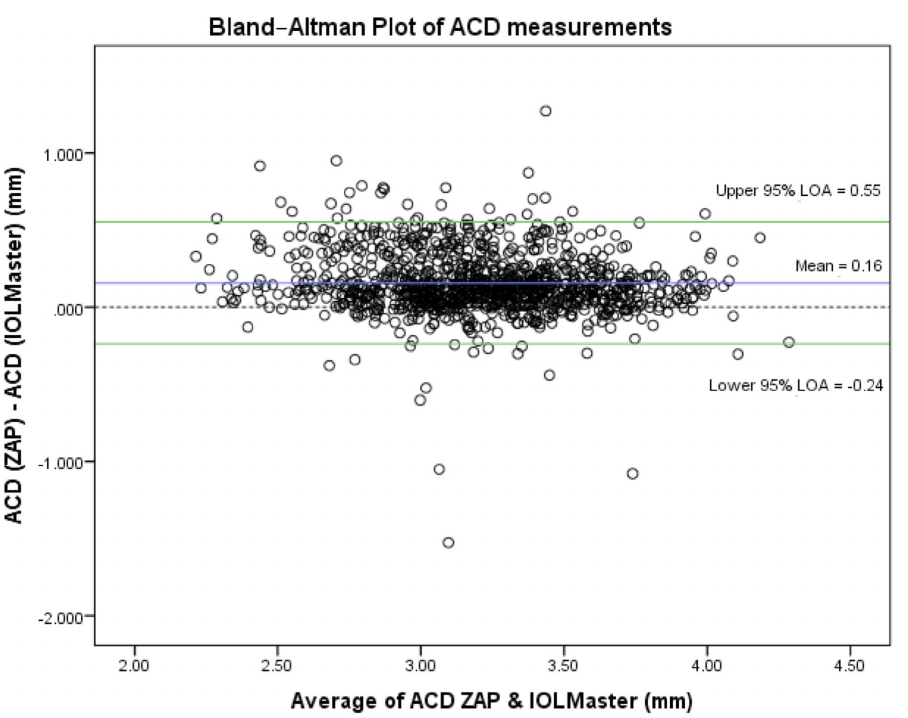
Figure 1. Bland-Altman plot of anterior chamber depth (ACD) measurements, with zero-line (blue line), mean difference (red line) and 95% limits of agreement (green dotted lines), comparing AS-OCT (ZAP) and IOLMaster. X-axis units=mm/Y-axis units=mm.